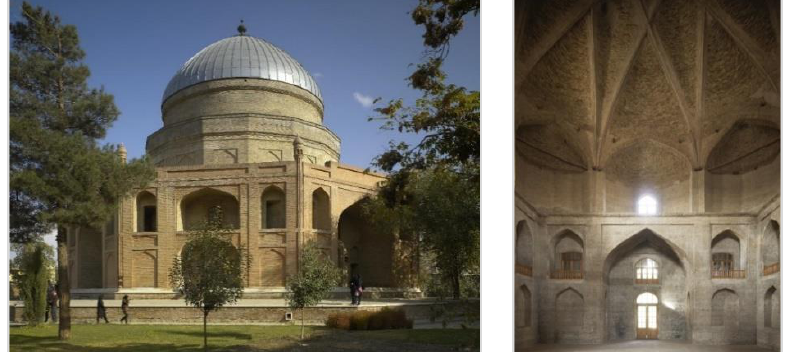
Figure 7 Timur Shah Mausoleum exterior and interior views (Jodidio,